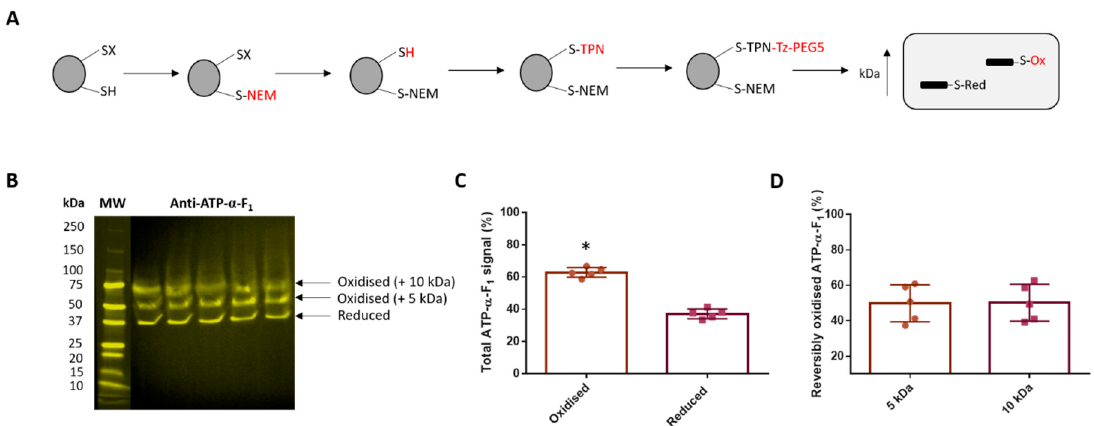
Figure 4. Reversible ATP- α -F1 oxidation is significant in oocytes. ( A ). Catalyst-free trans-cyclooctene- 6methyltetrazine (TCO-Tz) Click PEGylation scheme for reversibly oxidised thiols. Left to right: Reduced thiols are alkylated with NEM. Reversibly oxidised thiols are reduced with TCEP before being alkylated with TCO-PEG3-NEM (TPN). TPN labelled thiols are incubated with Tz-PEG5 to initiate the catalyst-free IEDDA Click reaction. Reversibly oxidised thiols are then mass shifted when assessed by Western Blot owing to a PEG induced electrophoretic mobility shift. ( B ). Western blot image showing reversibly oxidised (i.e., mass shifted 5 and 10 kDa bands) relative to reduced ATP- α -F 1 (i.e., lower band) in X. laevis oocytes ( n = 5). MW = molecular weight. ( C ). Percent reversibly oxidised (i.e., mass shifted) compared to reduced (unshifted) ATP- α -F 1 quantified. Percent reversibly oxidised ATP- α -F 1